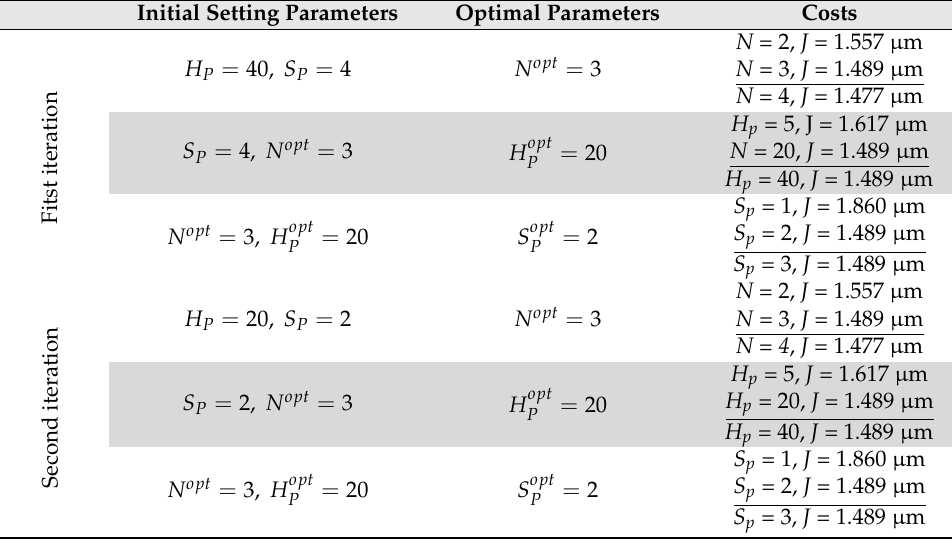
Table A2. Iterative parameter tuning for the PZT